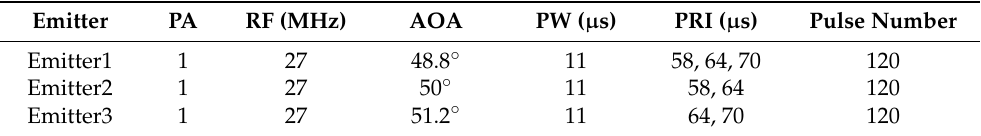
Table 6. Signal parameters of simulation